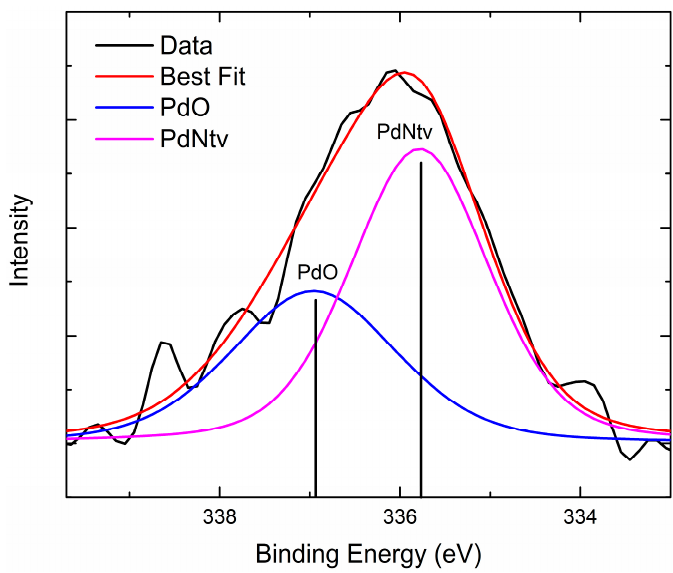
Figure 7. XPS (deconvoluted 3d 5/2 peak) of the catalyst. PdNtv, Palladium native oxide.